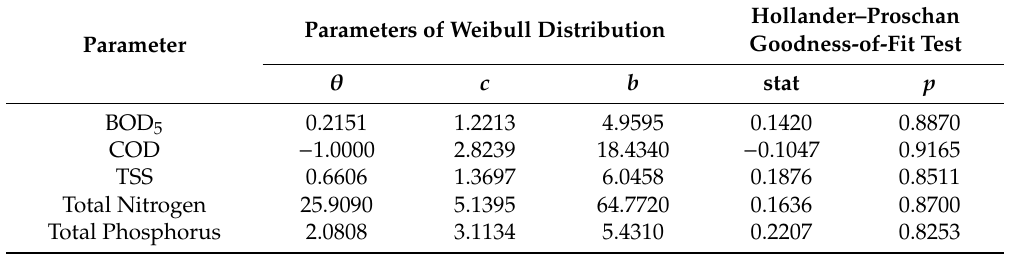
Table 5. Parameters of the Weibull distribution and the Hollander–Proschan goodness-of-fit test.